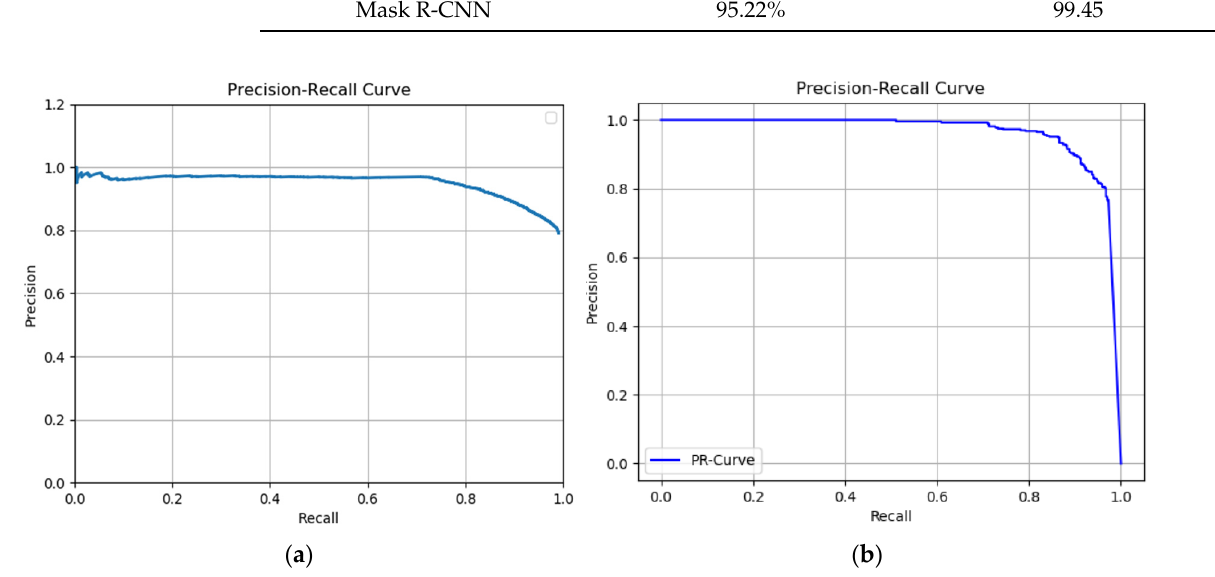
Figure 12. ( a ) Precision-recall curve of Faster R-CNN at learning rate = 0.001 in the testing set and ( b ) Precision-recall curve of Mask R-CNN at learning rate = 0.001 in the testing set.